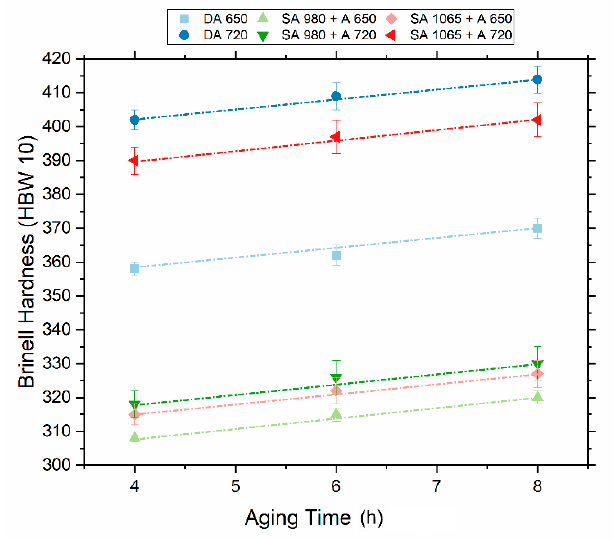
Figure 9. Hardness levels as an effect of all the heat treatment performed; dashed lines are the linear interpolations of the experimental points. All the linear regressions gave an R 2 value higher than 0.993 .